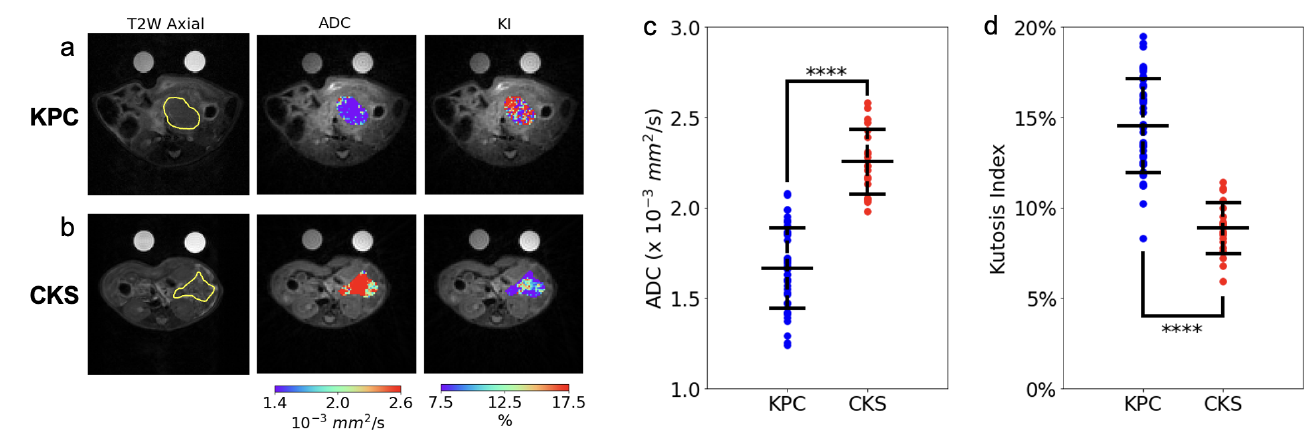
Figure 2. Comparison of quantitative in vivo DW-MRI markers between KPC and CKS tumors. ( a , b ) display a T2W axial image and tumor ADC (color) and KI (color) map overlays, for a KPC and CKS tumor, respectively. ( c , d ) present ADC and KI values from individual KPC (n = 44) and CKS tumors (n = 20) along with the group mean and standard deviation. p -values are from two-tailed t -tests. ****: p < 10 − 10